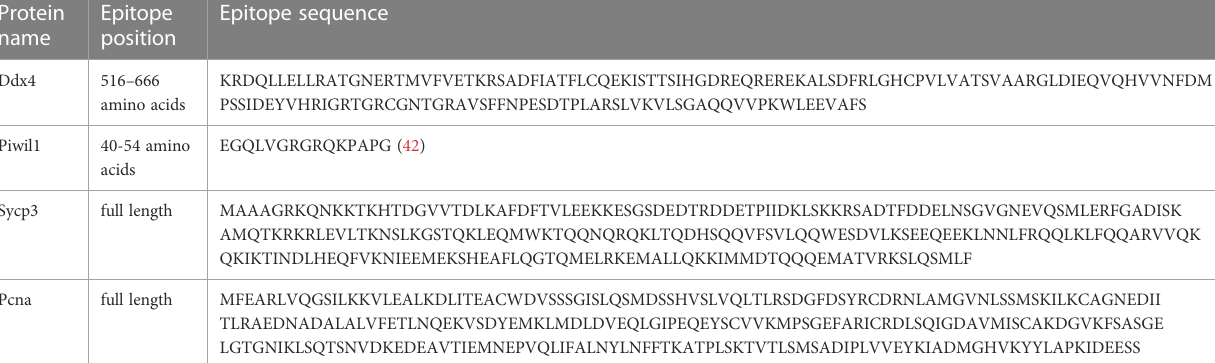
TABLE 1 The epitope sequences of the antibodies Ddx4, Pcna, and